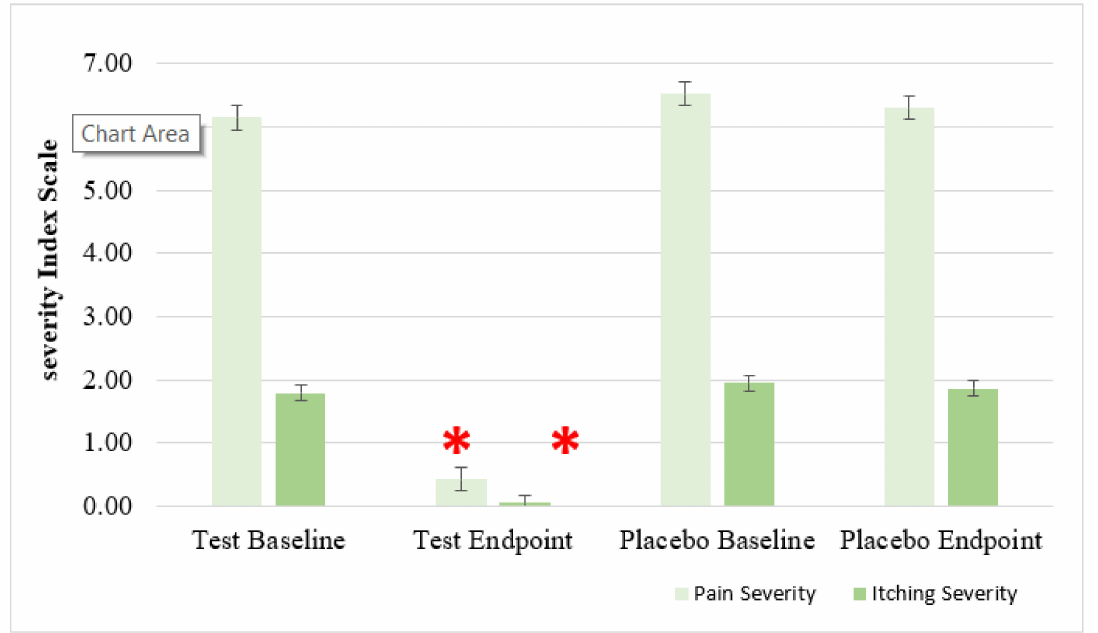
Figure 8. Effect of anti-hemorrhoidal polyherbal cream (HPC) on quality of life (QoL) of hemorrhoids (Degree 1–3), Pain (0–10 Scale) and Itching (0–3 Scale), compared to placebo. Total participants n = 77, HPC group. n = 54, placebo group. n = 23. * p < 0.01—significant as compared with